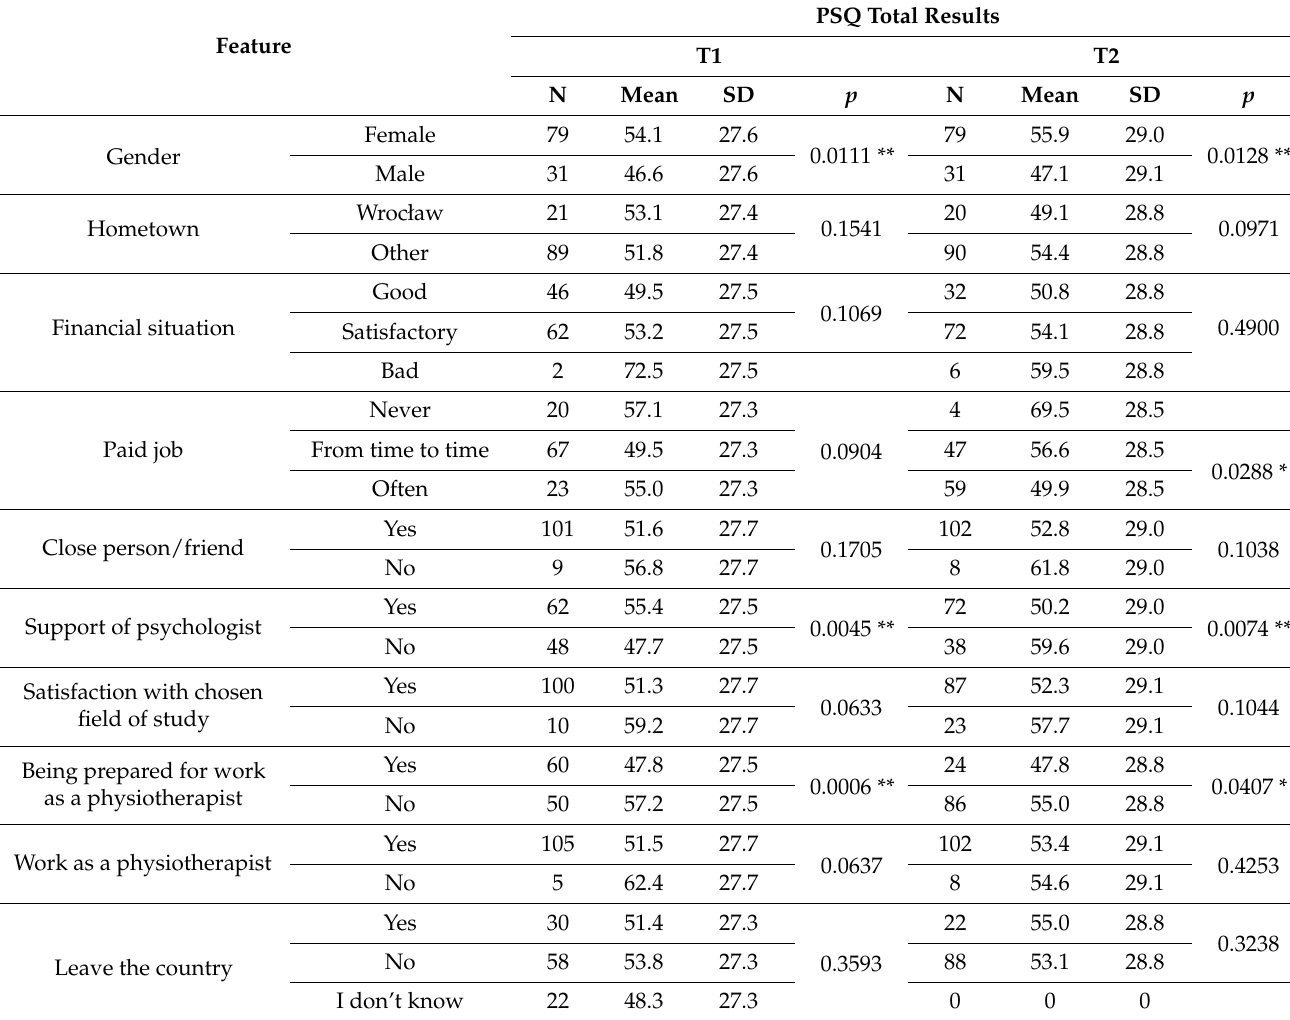
Table 4. The PSQ scores in T1 and T2 in selected groups of students (Student t -test for dependent groups or the ANOVA variance for three groups with at least five cases).